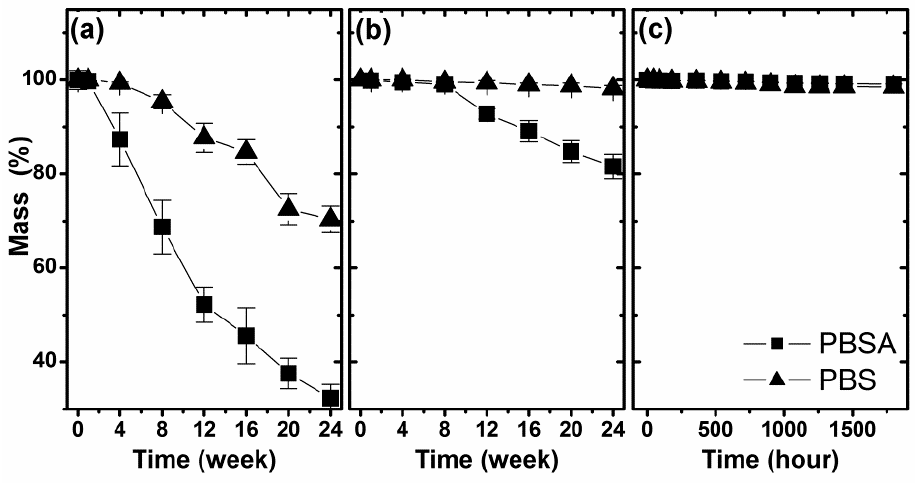
Figure 2. The mass changes of the studied samples during degradation in selected environments: ( a ) biodegradation in compost, ( b ) biodegradation in soil and ( c ) artificial weathering.